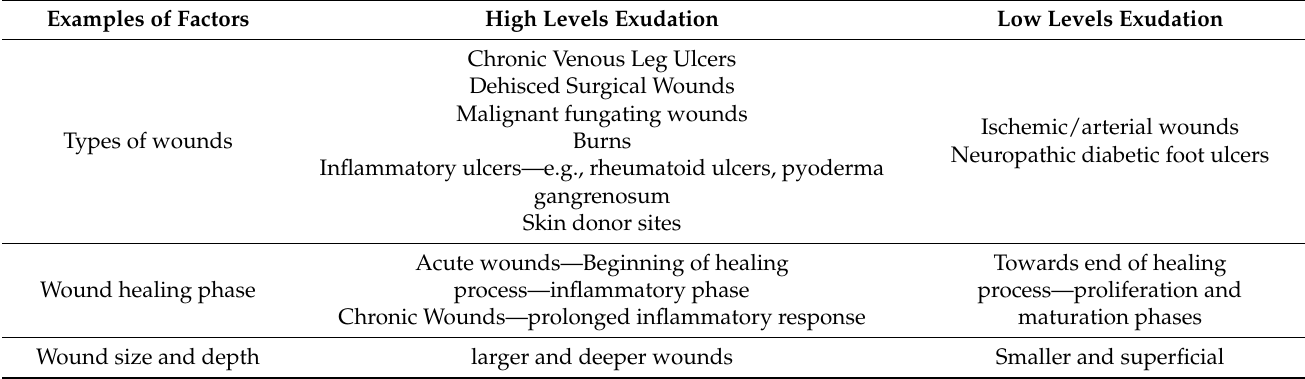
Table 1. Factors associated to Excessive or insufficient exudate production (adapted from [44–46]).